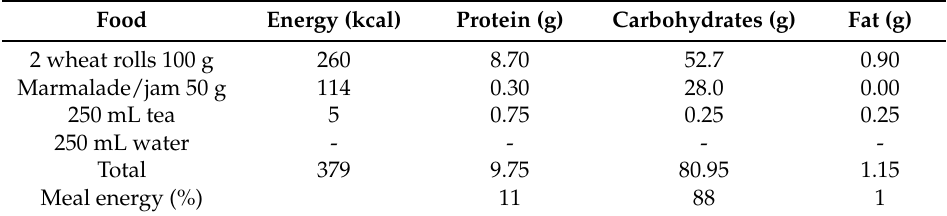
Table 2. Composition of the standardized breakfast 2 h prior to strenuous exercise tests. Food Energy (kcal) Protein (g) Carbohydrates